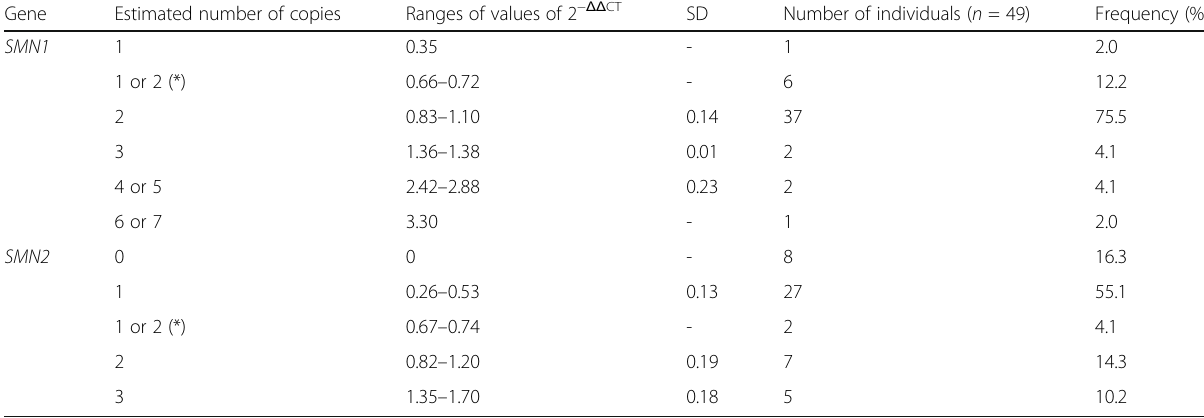
Table 1 Number of copies of SMN1 and SMN2 genes in the Venezuelan population sample